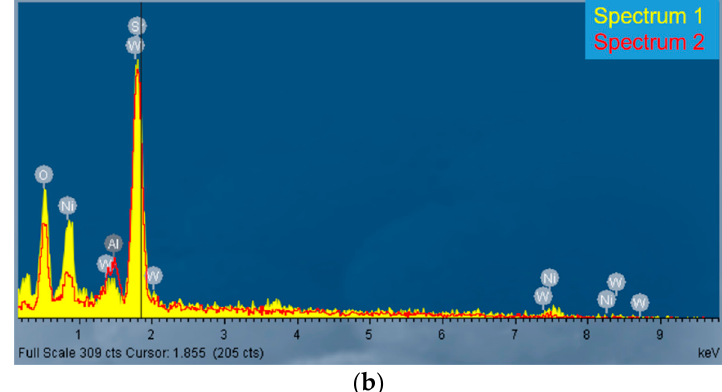
Figure 16. SEM micrograph ( a ) and EDS analysis ( b ) of WC -Ni.